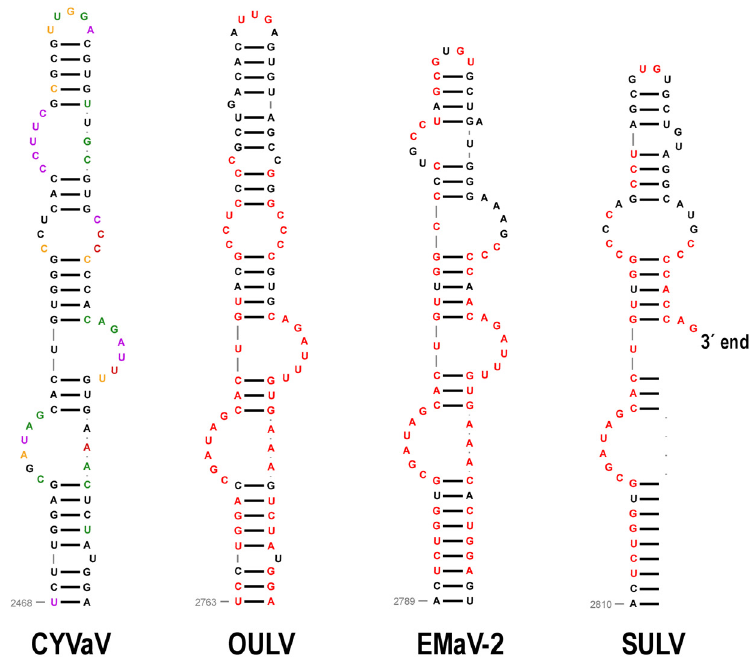
Figure 11. Structure 14 in Class 2 ulaRNAs. This structure has been identified as a 3 ′ CITE (J. Liu and A.E. Simon, unpublished). SHAPE data is shown on the CYVaV structure. Red bases in the other ulaRNA Structure 14 are identical to those of CYVaV. The reported SULV sequence terminates within this structure and thus the sequence is unlikely to be full-length as reported [20]. This element is not conserved in the Class 1 and Class 3 ulaRNAs, which must contain different 3 ′ CITEs.